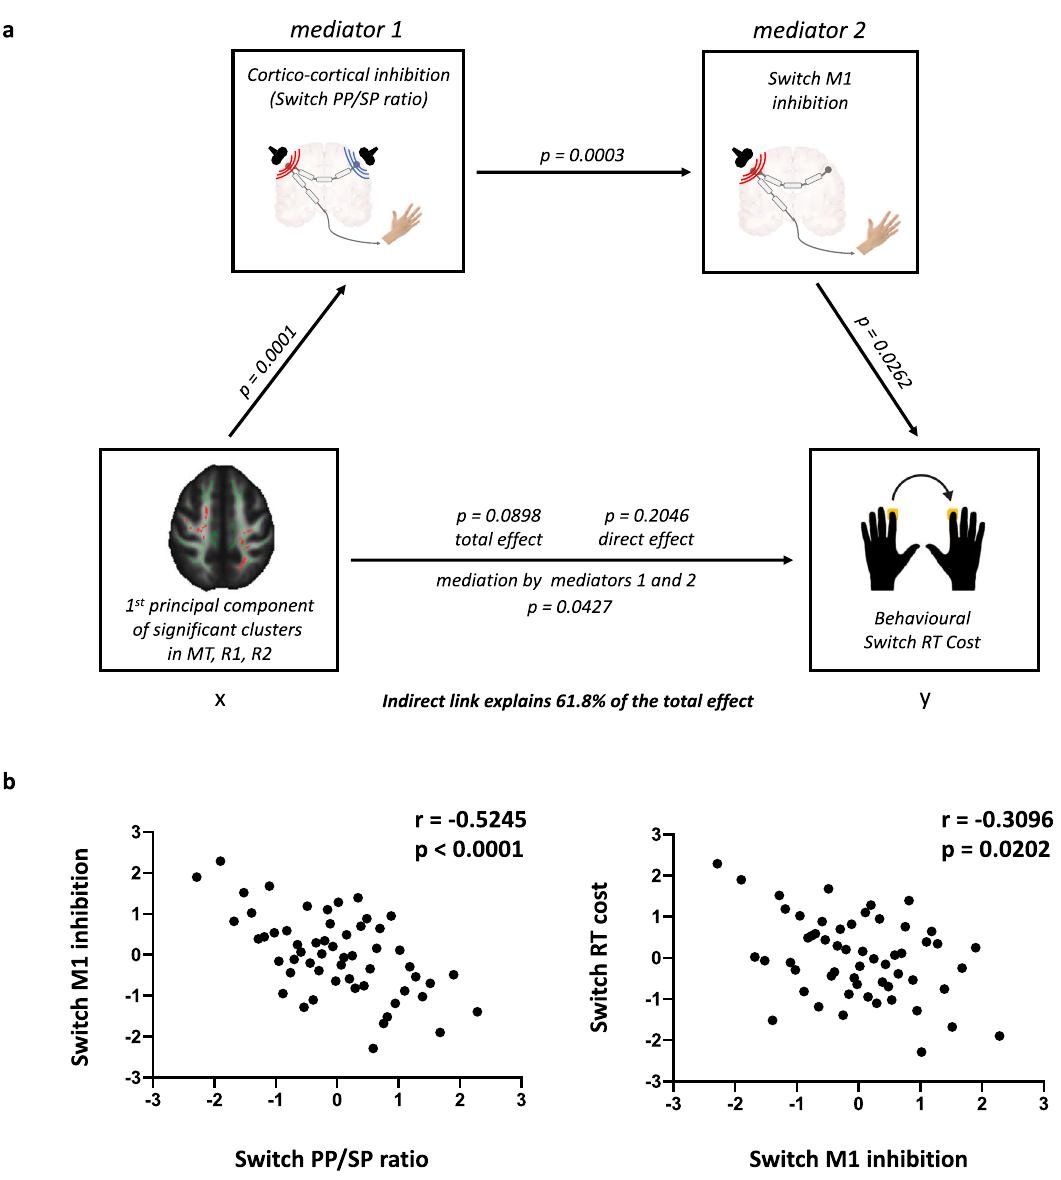
Fig. 3 Motor network physiology links myelination to switching behaviour. a Mediation analysis reveals an indirect link between the myelin-related measure of interhemispheric cortico-cortical inhibition (Box X) and switch RT cost, a metric of performance during the action reprogramming task (Box Y). The 95% boostrapped CI for the indirect effect of sequential mediation of M1 and M2 is − 0.29 to − 0.02, which overall explained 61.8% of the total effect. b Inhibition from PMv to M1, as measured by ppTMS, correlates with switch M1 inhibition ( r = − 0.5245, p < 0.0001). Switch M1 inhibition correlates with action reprogramming behaviour, as measured by switch RT cost ( r = − 0.3096, p =